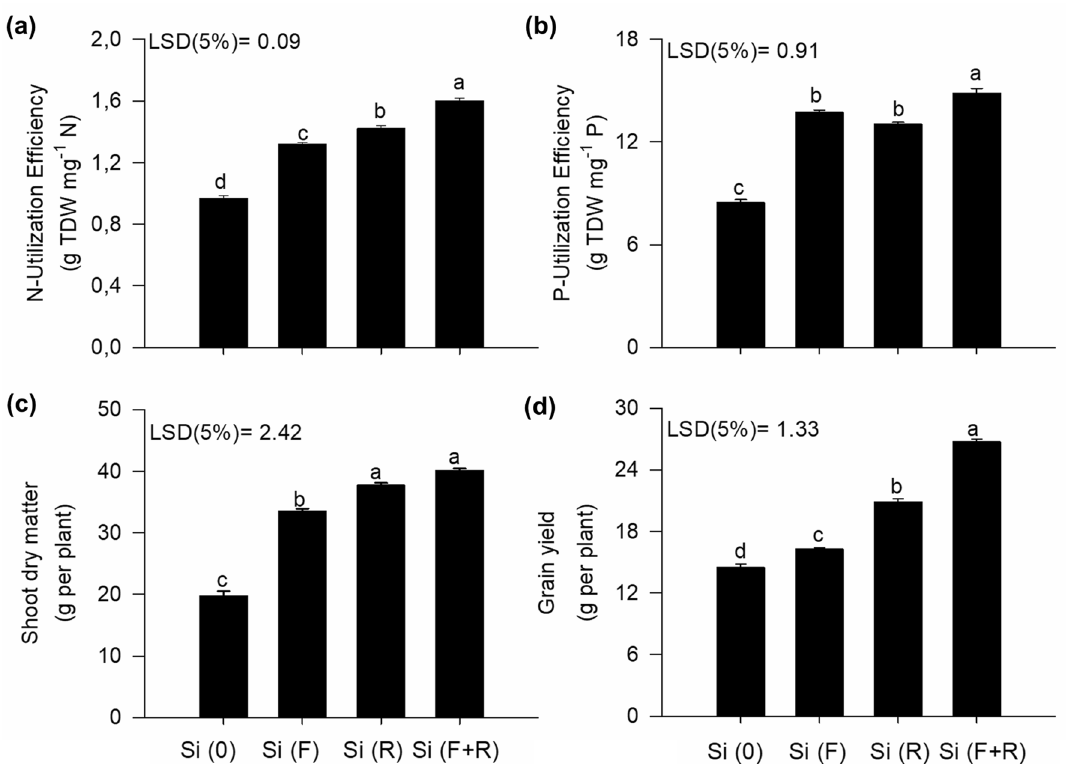
Figure 3. Use efficiency of N ( a ) and P ( b ), shoot dry mass ( c ) and grain productivity ( d ) in quinoa grains, according to different forms of Si application; no Si [Si(0)]; foliar Si application [Si(F)]; root Si application [Si(R)]; combination between root and foliar application [Si(F + R)]. Letters indicate significant differences between the forms of Si application (p < 0.05); least significant difference [LSD]. The vertical bars represent the standard error of the